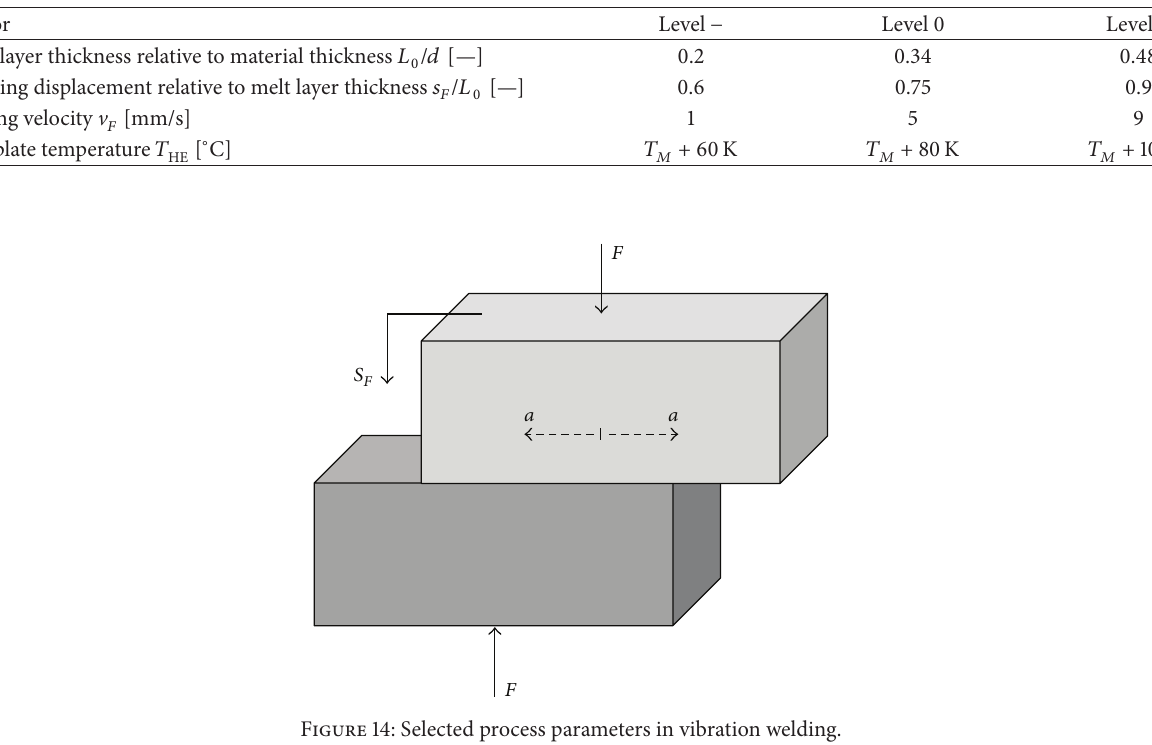
Table 3: Variation of welding parameters in hot plate welding.